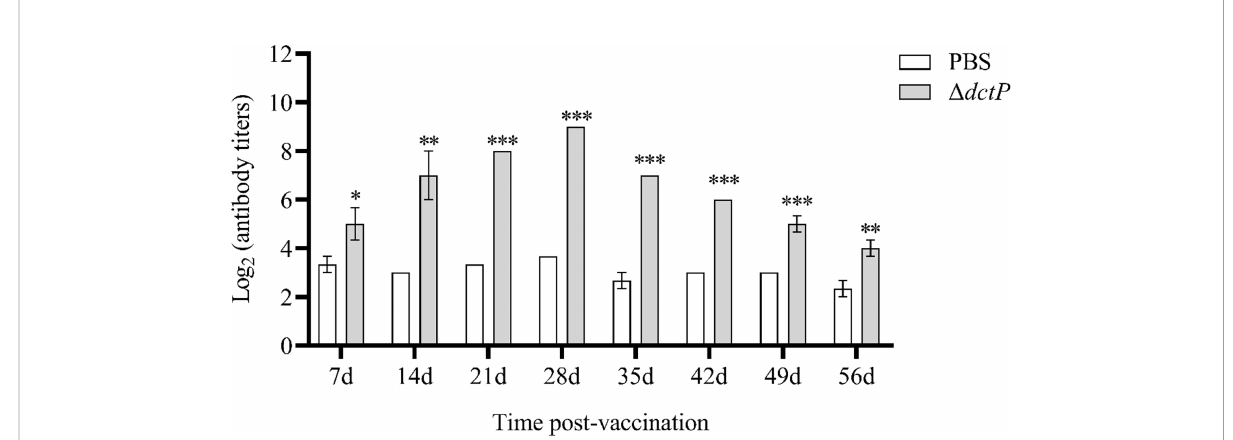
FIGURE 7 Analysis of V. alginolyticus -speci fi c serum antibody titers of IgM at 7d, 14d, 21d, 28d, 35d, 42d, 49d, and 56d post-vaccination. Speci fi c antibody titers were detected by ELISA. Bars represented the mean relative expression (n = 3) and error bars represent standard errors. The asterisks